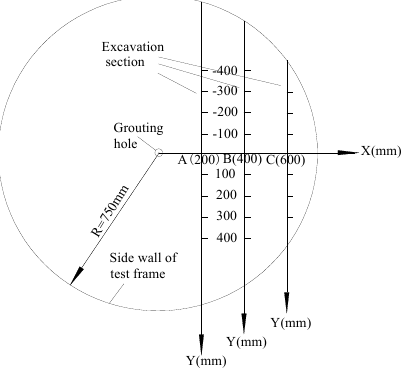
Figure 4. Location of excavation section.